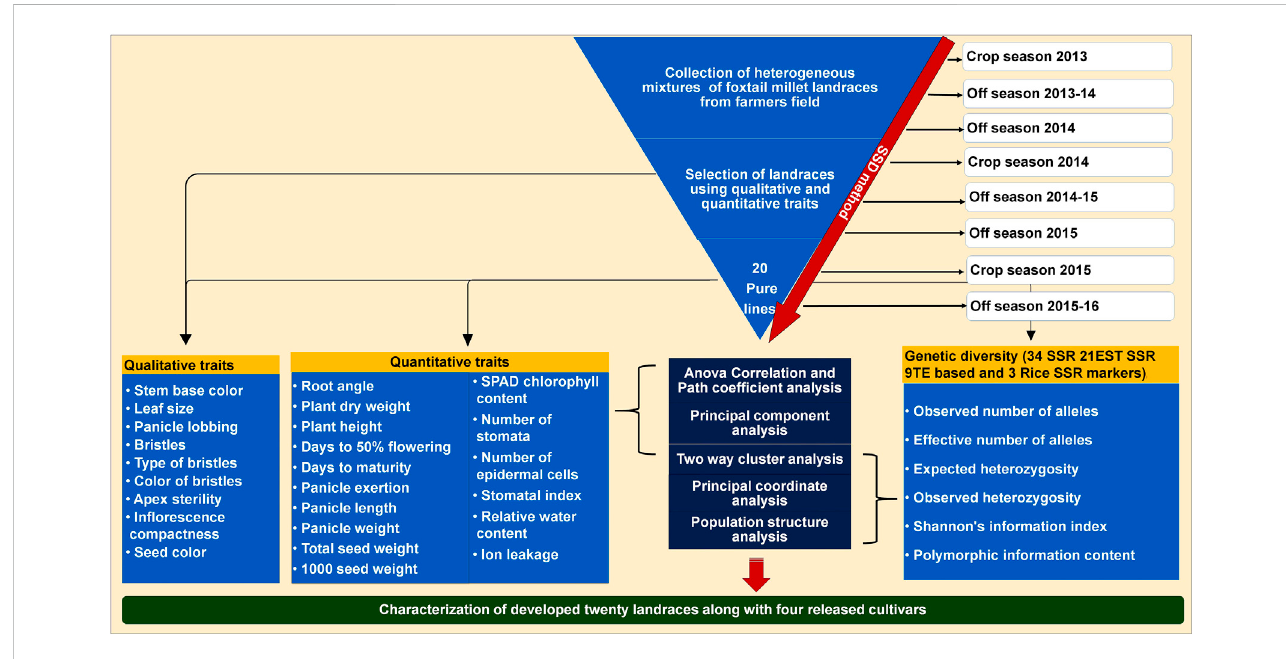
FIGURE 1 Scheme for twenty foxtail millet landraces development process based on SSD method using from collected heterogeneous mixture in farmer fi elds. Details of the characterization of these landraces along with released cultivars based on qualitative, quantitative traits and molecular